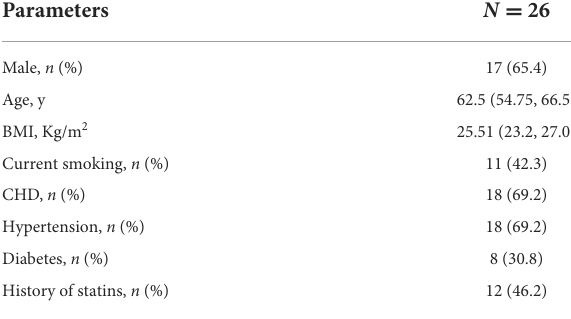
TABLE 1 Study population